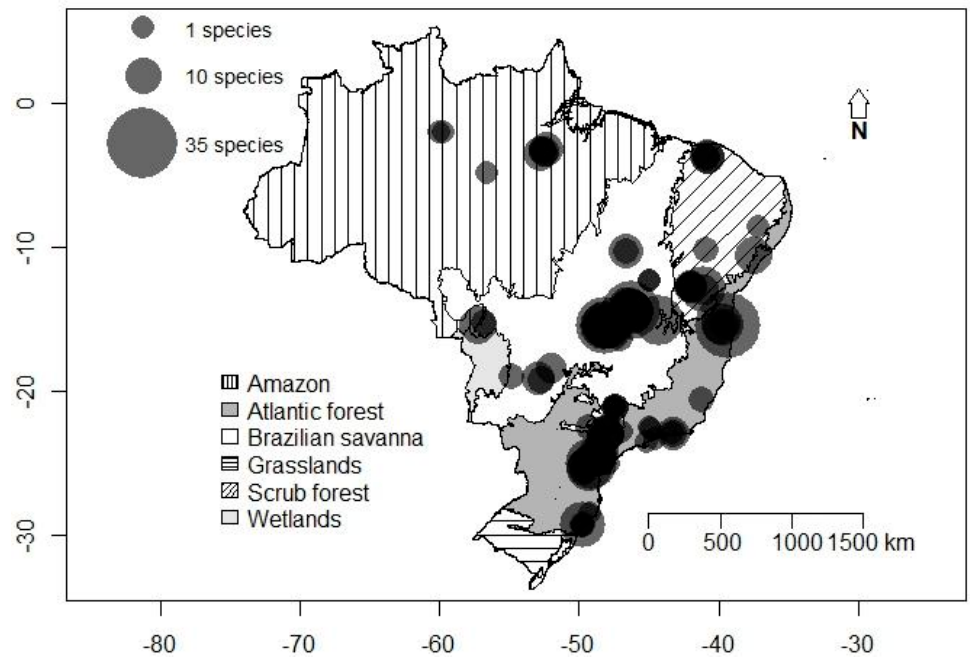
Figure 1. Richness of cave-dwelling bats in the Brazilian biomes. Vertical lines: Amazon; White: Brazilian savanna; Diagonal lines: scrub forest; Light gray: wetlands; Dark gray: Atlantic forest; Horizontal lines: grasslands.